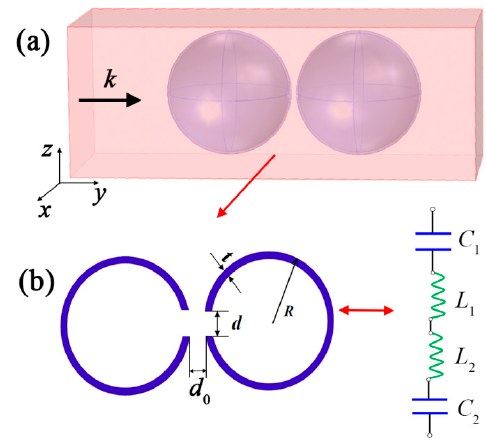
Figure 1. ( a ) The 3D schematic diagraph of DSSHS in acoustic waveguide; ( b ) the cross-sectional diagram of DSSHS and the acoustic effective L-C circuit.